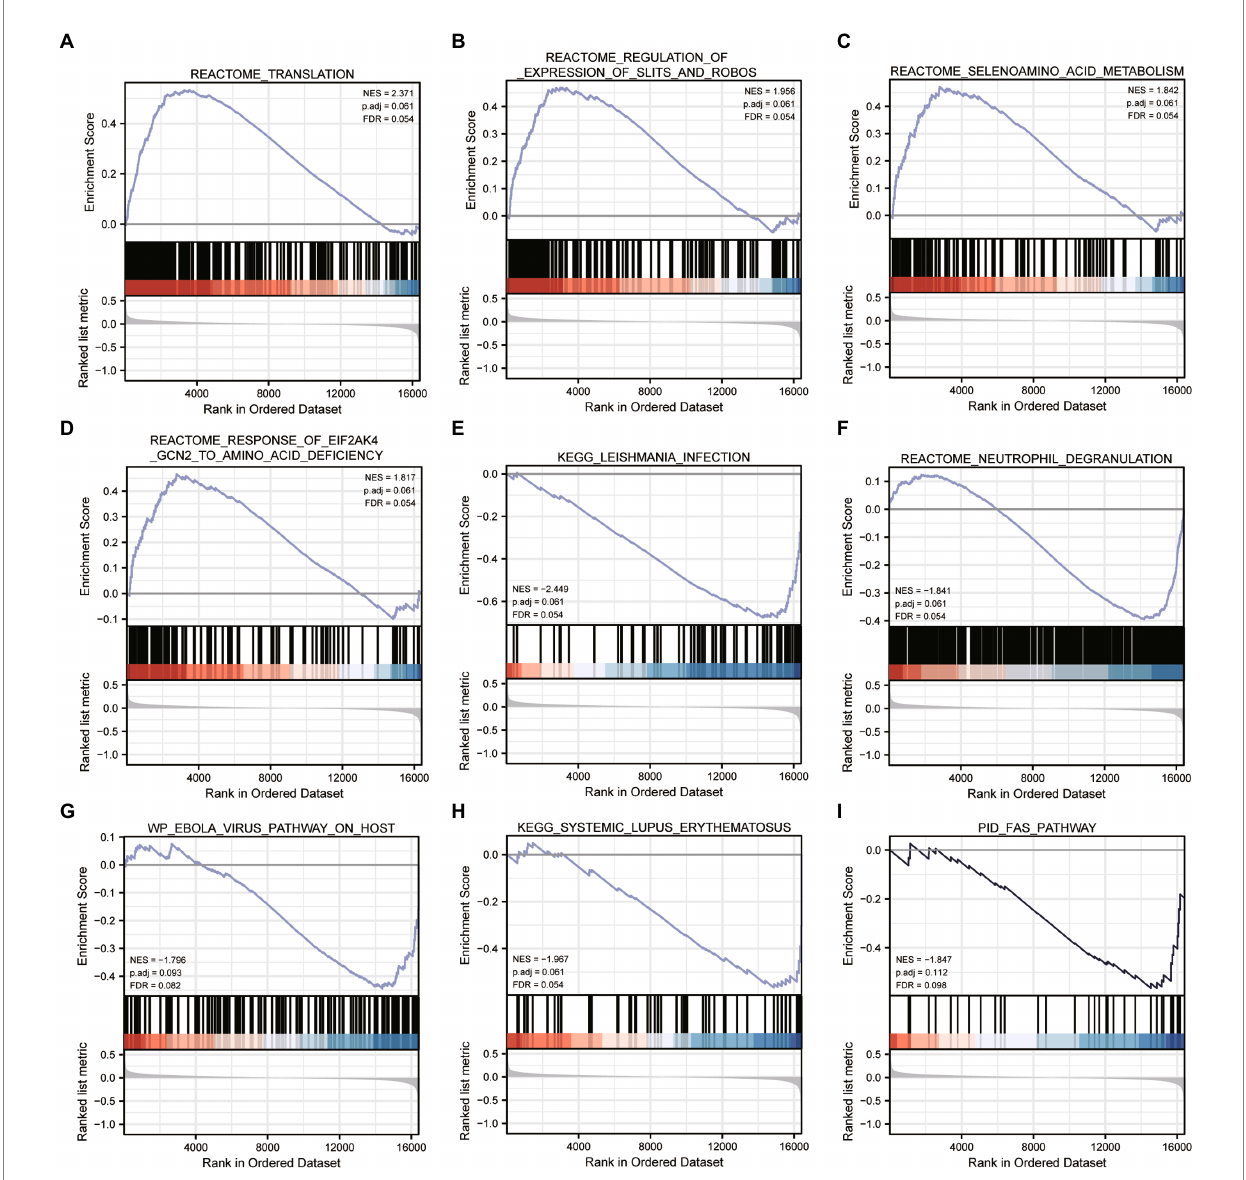
FIGURE 7 Gene Set Enrichment Analysis between ASD clusters. (A-I) Enrichment plots of pathways in c2.cp.all.v7.2.symbols.gn in ASD subcluster 2 obtained after GSEA